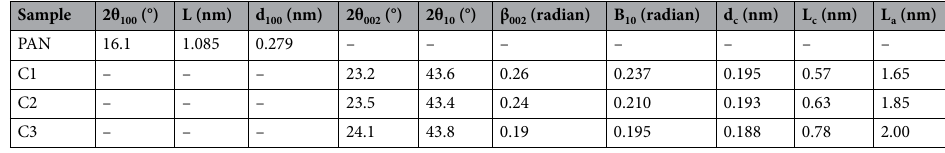
Table 1. The average interplanar spacing ‘‘d”, the crystallite thickness ‘‘L c ’’, and layer plane length ‘‘L a ’’ of as-electrospun PAN and carbonized PAN fibers.